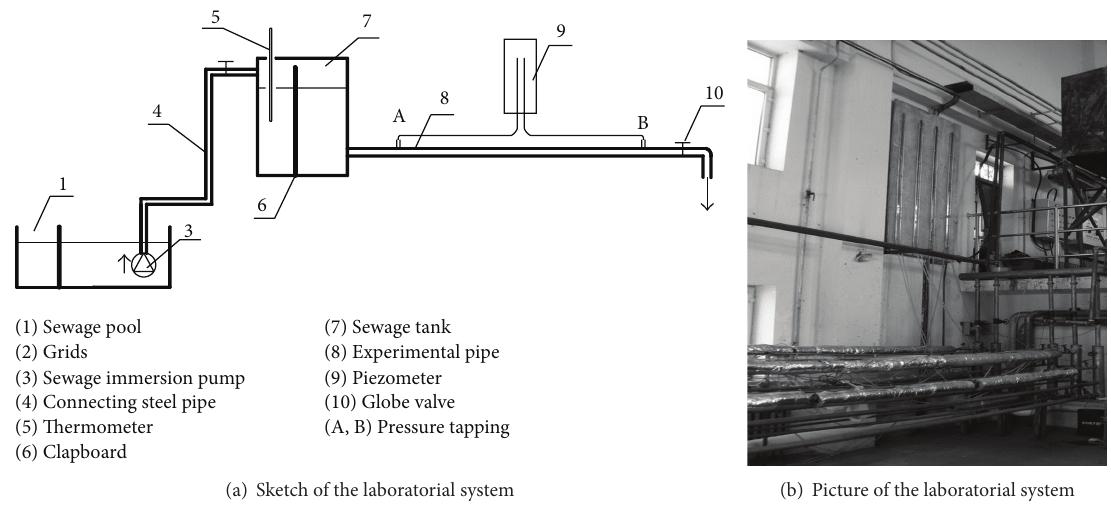
Figure 1: Sketch of the laboratorial